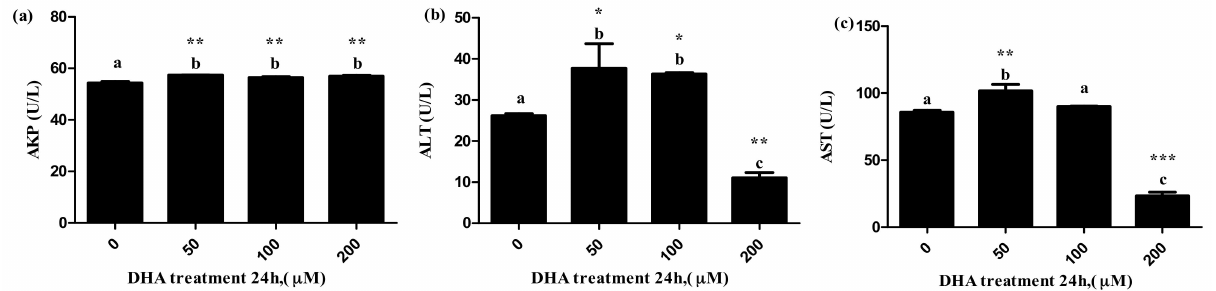
Figure 4. The effects of DHA-treated BRL-3A for 24 h on the activity of AKP ( a ), ALT ( b ) and AST ( c ) in the supernatants ( n = 3). Values are means with SEM, the SEM was presented by vertical bars ( n = 3); means with different letters are significantly different from one another ( p < 0.05) as determined by variance analysis followed by multiple comparisons with LSD post-hoc test; * statistically significant differences vs. control ( p < 0.05); ** statistically significant differences vs. control ( p < 0.01); *** statistically significant differences vs. control ( p < 0.001).